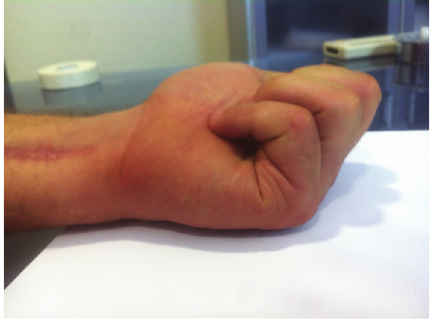
Figure 2: 6 months after surgery.